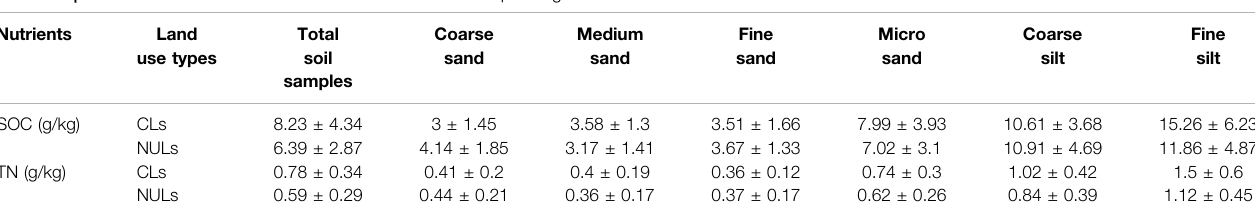
TABLE 2 | SOC and TN contents between the old CLs and corresponding NULs.